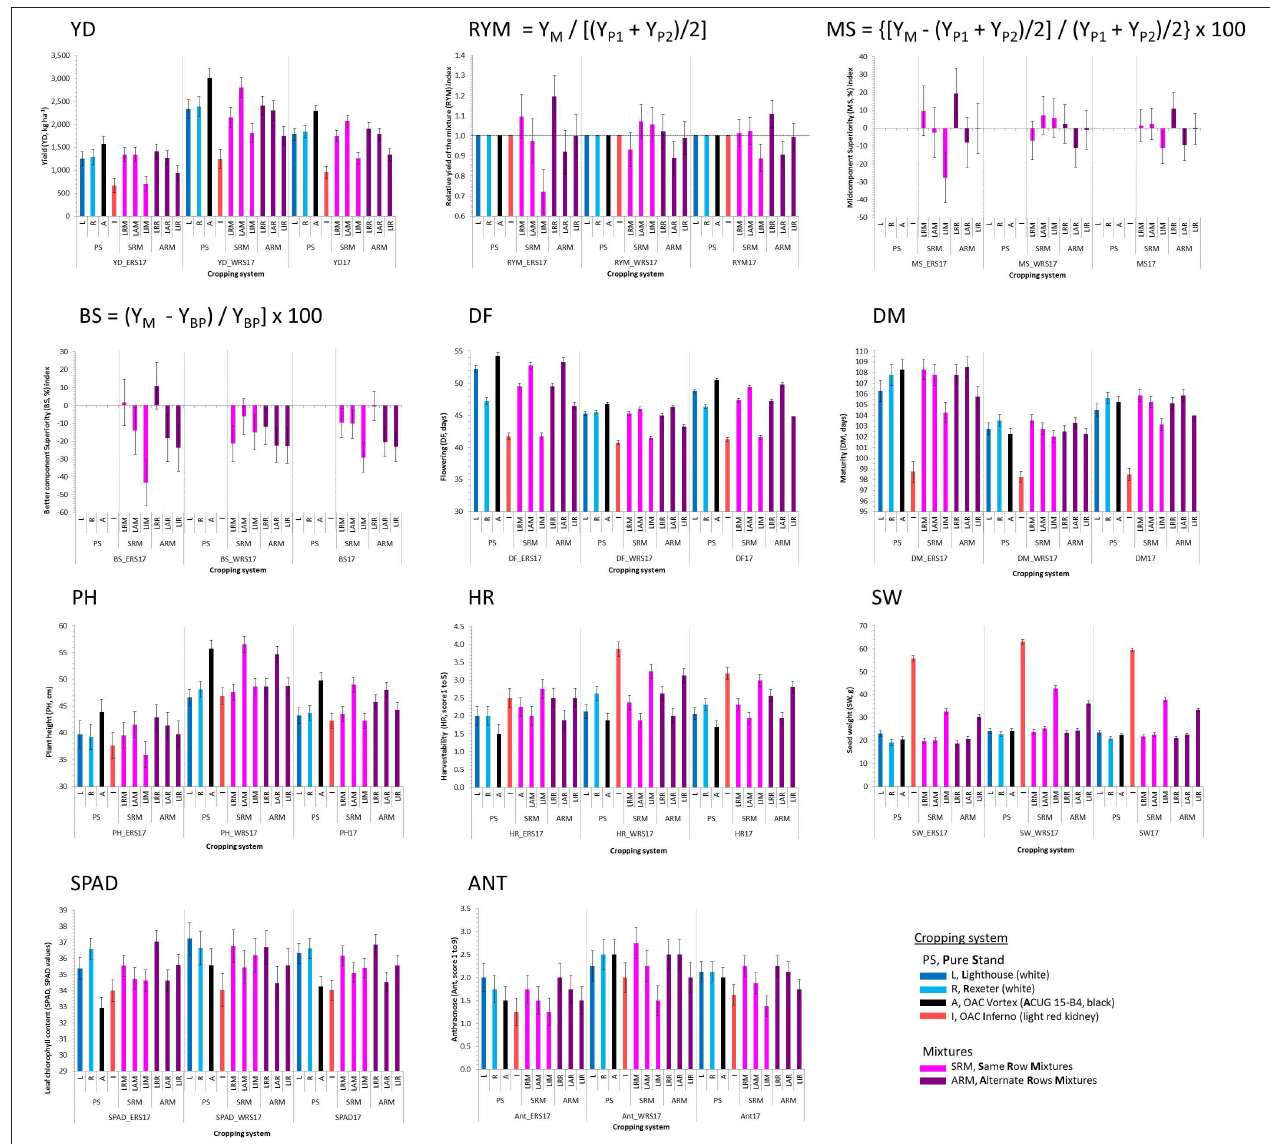
FIGURE 2 | Trait means and standard errors of the four common bean genotypes evaluated in pure stands and binary mixtures [same row mixture (SRM) and alternate rows mixture (ARM)] at two Ontario locations [Elora (ERS) and Woodstock research stations (WRS)] in 2017 (pilot) study. Traits: Yield (YD, kg ha − 1 ), three yield-based indices [relative yield of the mixture (RYM), midcomponent superiority (MS), and better component superiority (BS)] and seven other traits [days to flowering (DF, days), days to maturity (DM, days), plant height (PH, cm), harvestability (HR, scale 1–5), seed weight (SW, g), and leaf chlorophyll content (SPAD, SPAD